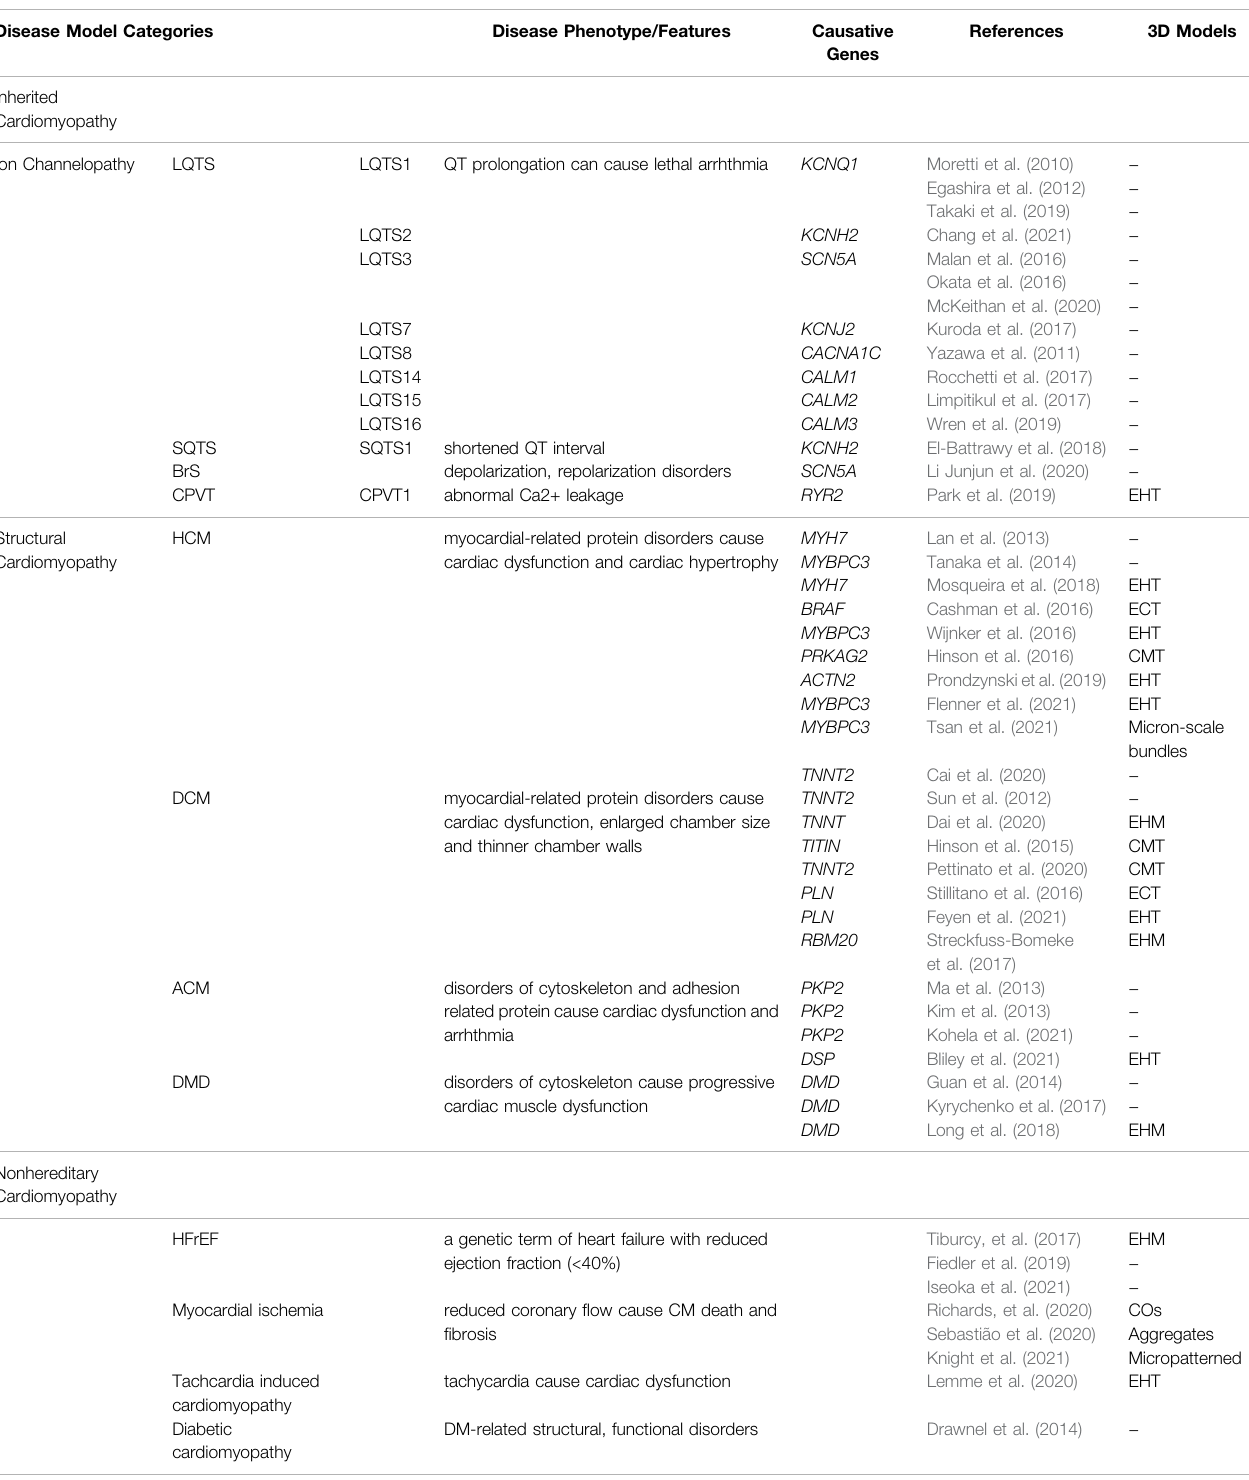
TABLE 2 | Lists of disease-speci fi c hPSC-CM